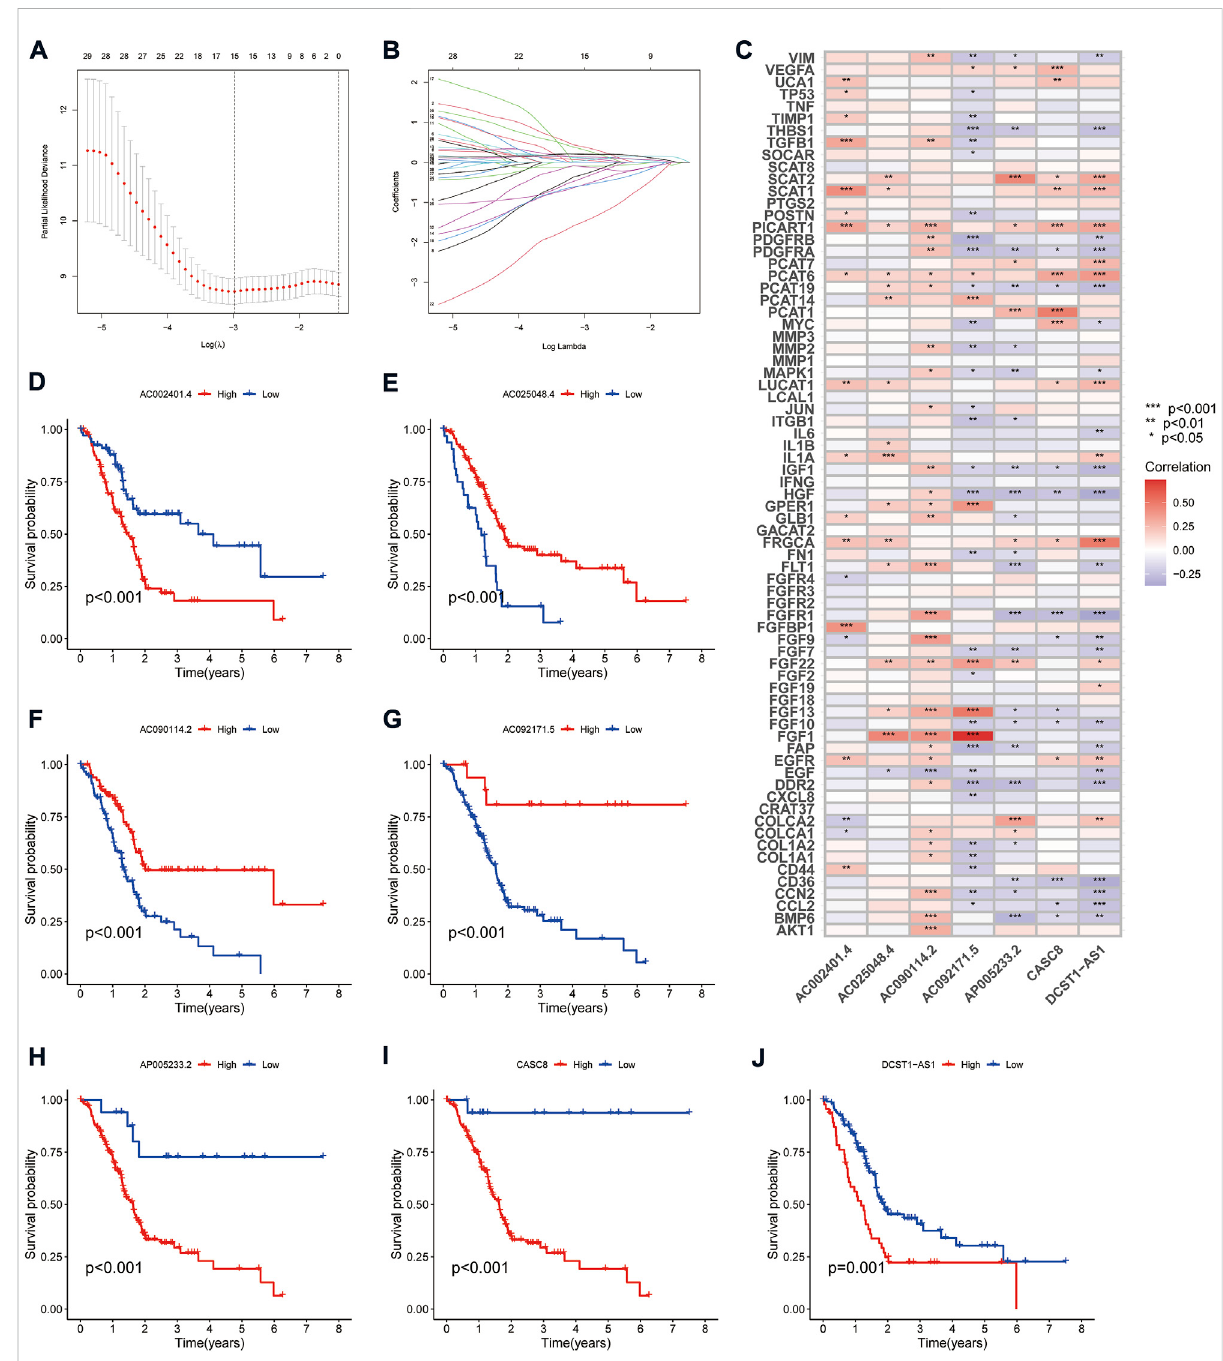
FIGURE 2 Derivation and selection of the CAFs-associated lncRNAs signature in the training cohort. (A,B) LASSO coef fi cient and partial likelihood deviance of the prognostic signature. (C) Heat map showing the correlation between the expression of seven lncRNAs and CAFs-related genes. (D – J) Kaplan-Meier curves analyzed the correlation between the expression of the seven crucial lncRNAs and the prognosis of